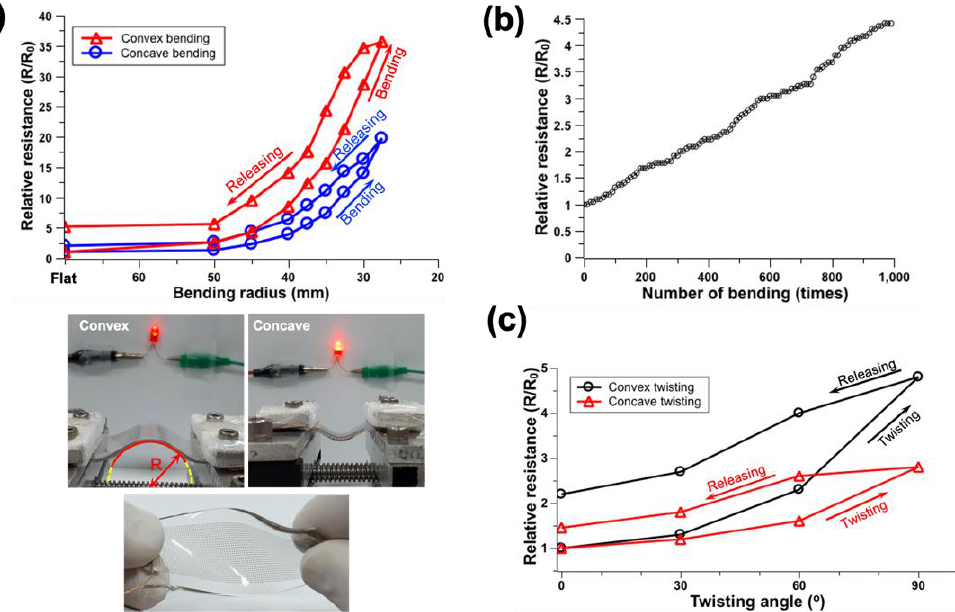
Figure 5. Mechanical and electrical performance tests of straight meshed-type pattern on PDMS. ( a ) Relative resistance change by different bending radius change, ( b ) relative resistance change in repeated bending with a bending radius of 55 mm, and ( c ) relative resistance change by different twisting angle.